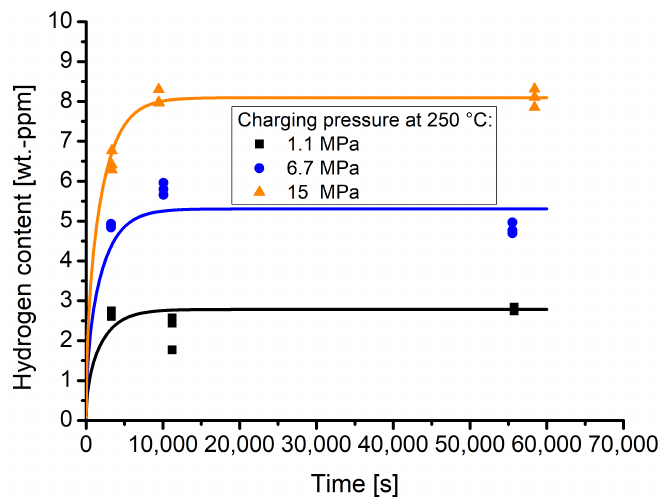
Figure 6. Time and pressure dependent hydrogen contents as well as sorption curves, calculated according to the estimated diffusion coefficient at 250 ◦ C of D= 1.64 × 10 − 10 m 2